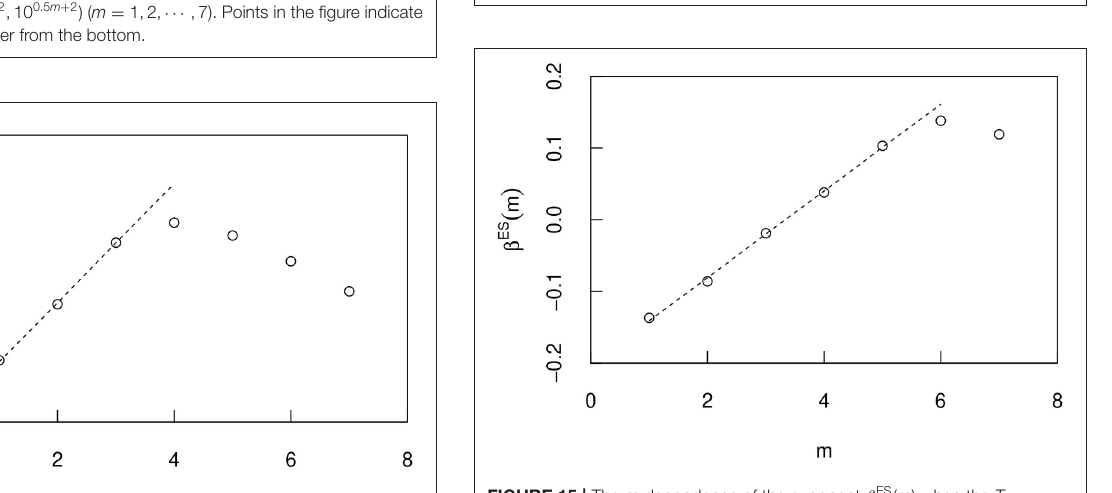
FIGURE 15 | The m dependence of the exponent β ES ( m ) when the T dependence of the geometric mean h x T i is approximated by an exponential function e β ES ( m ) T in a Spain simulation. The errors are so small that they do not appear in the figure, and they are therefore